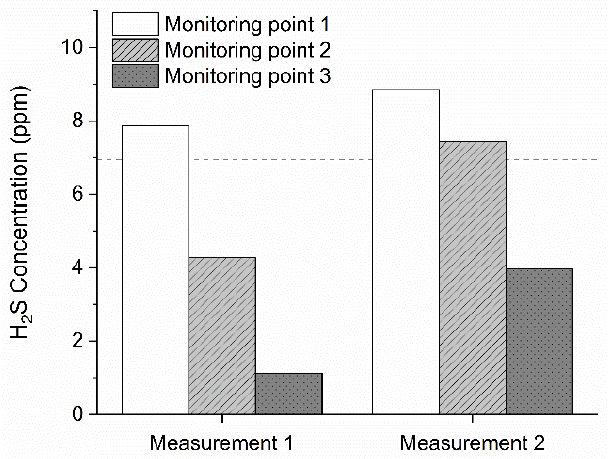
Figure 2. Onsite data of H 2 S at 1.5 m height. The dotted line is the occupational exposure standard for H 2 S in China, which is 10 mg/m 3 = 6.9 ppm.